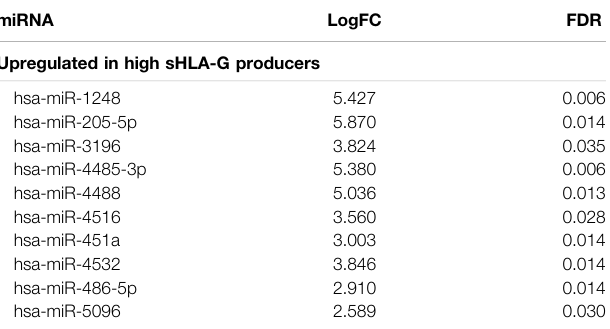
TABLE 2 | miRNAs differentially expressed between childhood ALL high and low soluble HLA-G producers with FDR ≤ 0.05. miRNA LogFC FDR Upregulated in high sHLA-G